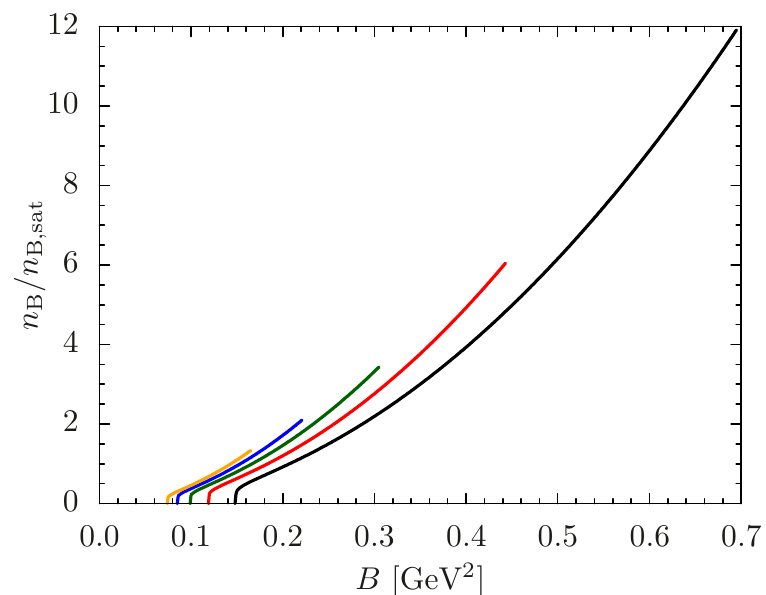
Figure 6 . Spatially averaged baryon number density carried by the CSL in units of the nuclear saturation density. The individual curves correspond to the values of (cid:22) of 400 MeV (black), 500 MeV (red), 600 MeV (green), 700 MeV (blue), and 800 MeV (orange). For each curve, the onset of nonzero baryon density corresponds to B CSL , whereas the endpoint indicates the BEC instability at the critical (cid:12)eld B BEC